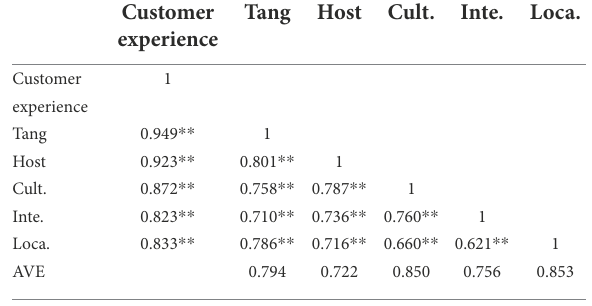
TABLE 2 Correlation matrix of five dimensions of customer